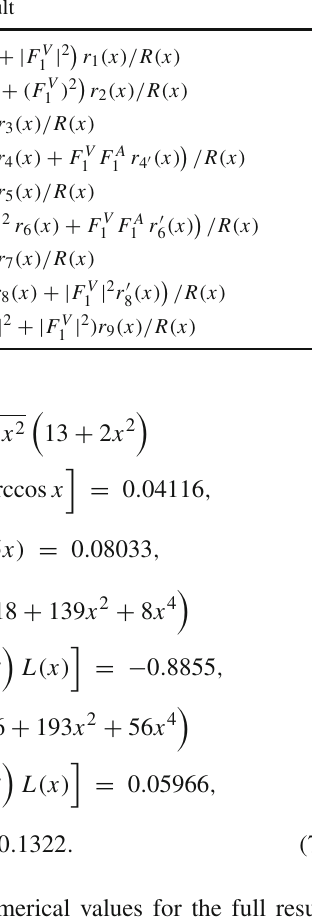
Table 2 Asymmetries in neutron β decay. First column: asymmetry; secondcolumn:analyticalexpressionforLOresult (cid:8) umn: full result; fourth column: numerical value of the lo result; fifth Observable LO result